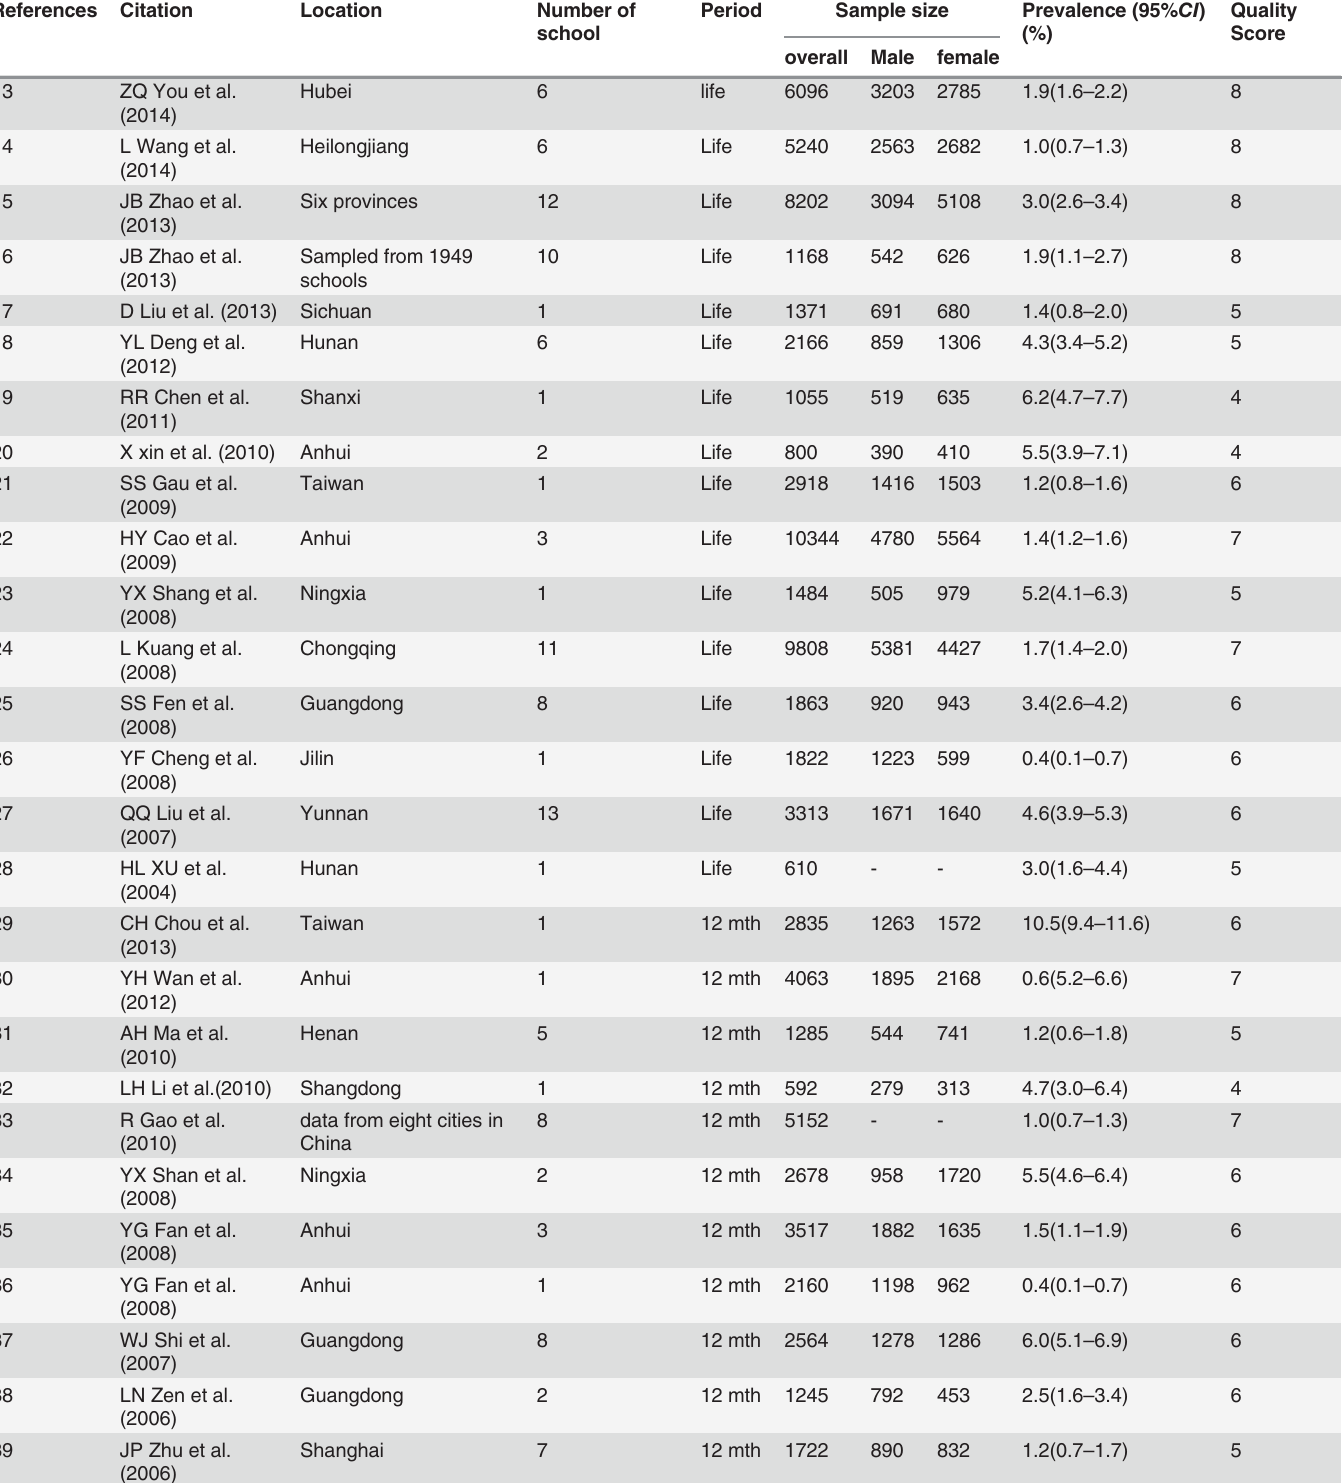
Table 1. Key features of the included